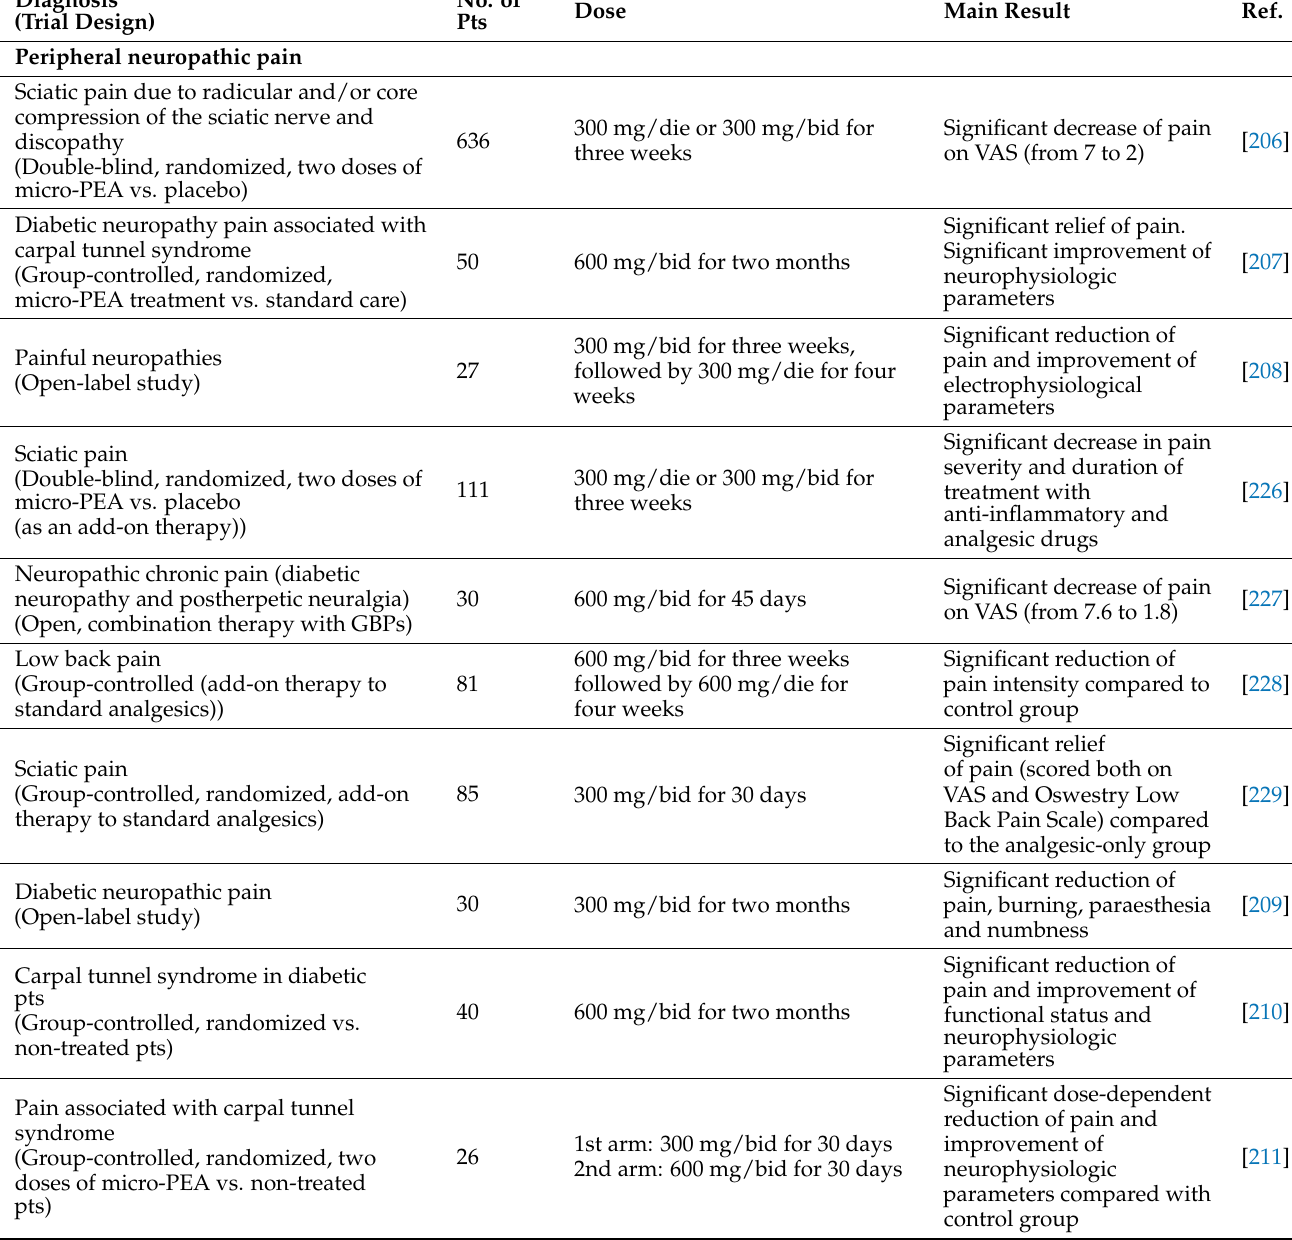
Table 5. Pain relieving effect of micro-PEA (i.e., PEA-m or PEA-um) on chronic neuropathic pain: overview of human trials in chronological